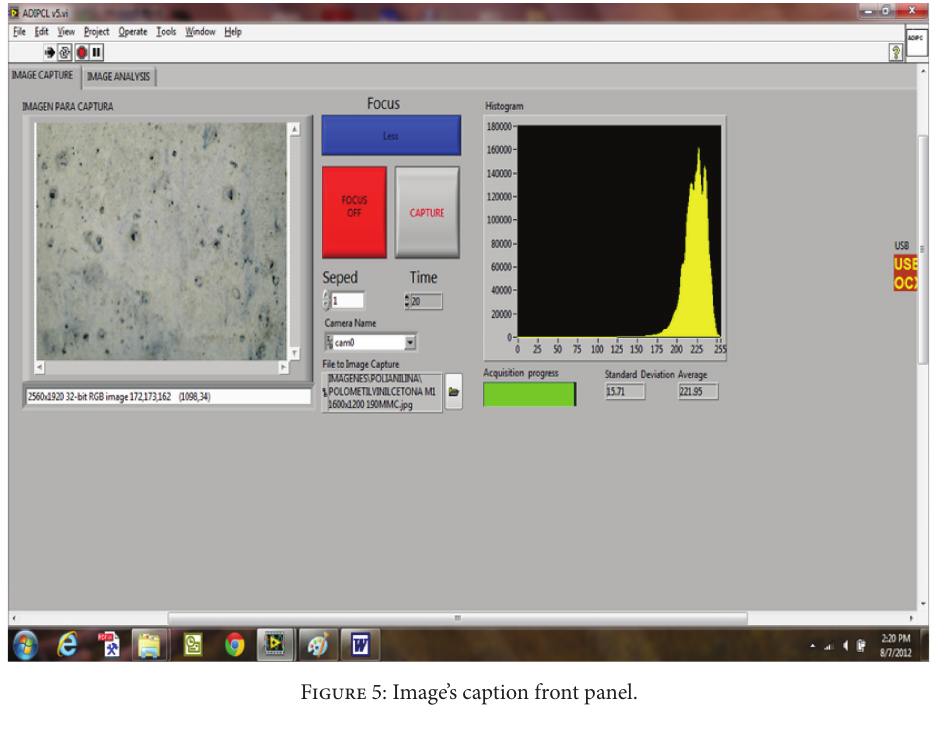
Figure 5: Image’s caption front panel.